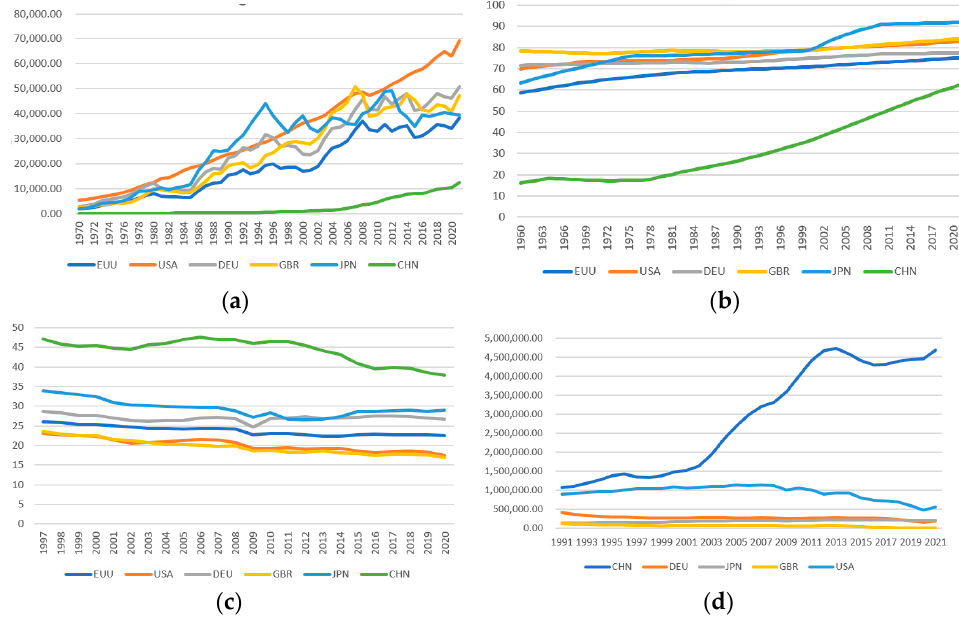
Figure 2. ( a ) GDP per capita (current USD); ( b ) urbanization rate; ( c ) proportion of secondary in- dustry; ( d ) coal consumption (MST); data source: National accounts data files of the World Bank and the OECD; United Nations, World Urbanization Prospects; U.S. Energy Information Admin- istration.